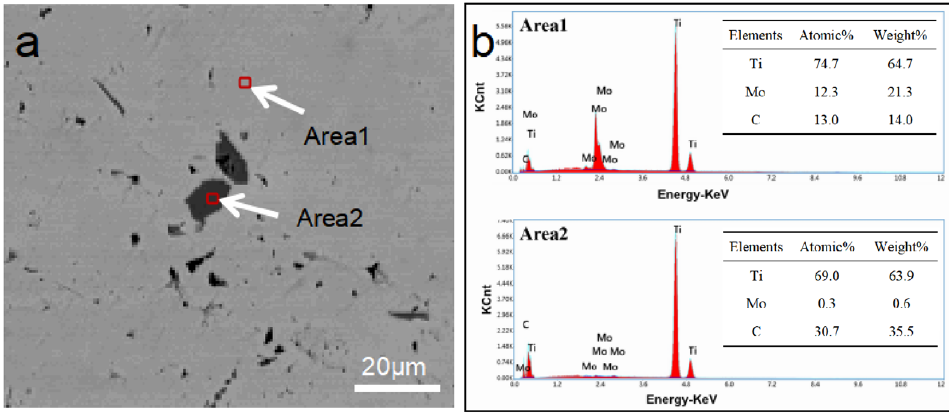
Figure 4. ( a ) SEM image of Ti-30Mo-0.5TiC alloy, ( b ) EDS analysis of relevant regions in ( a ).